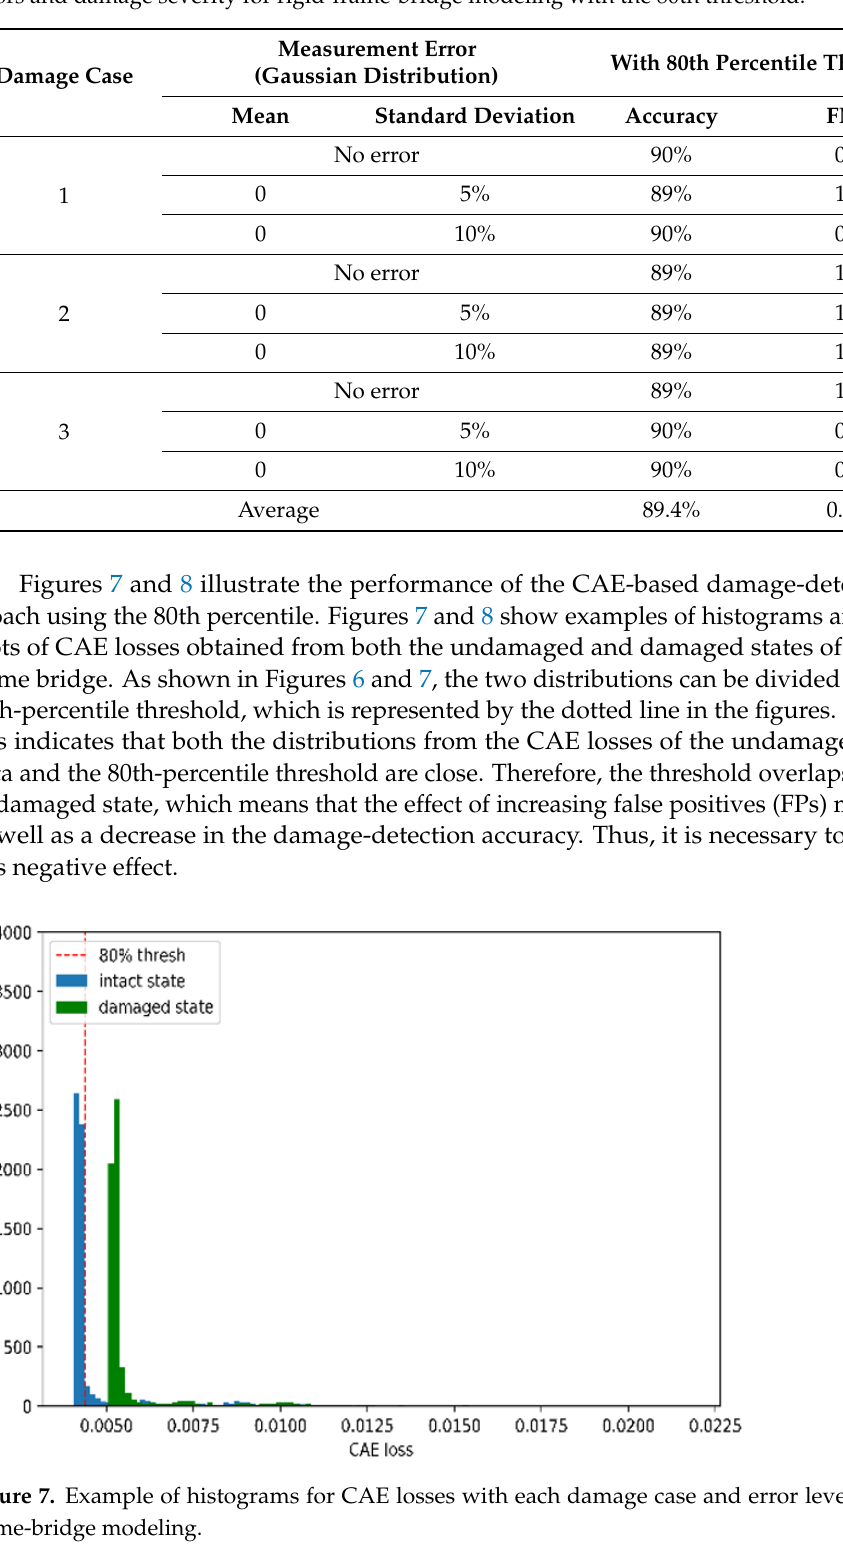
Table 3. Accuracies and FNRs of the CAE models corresponding to three levels of measurement errors and damage severity for rigid-frame-bridge modeling with the 80th threshold.